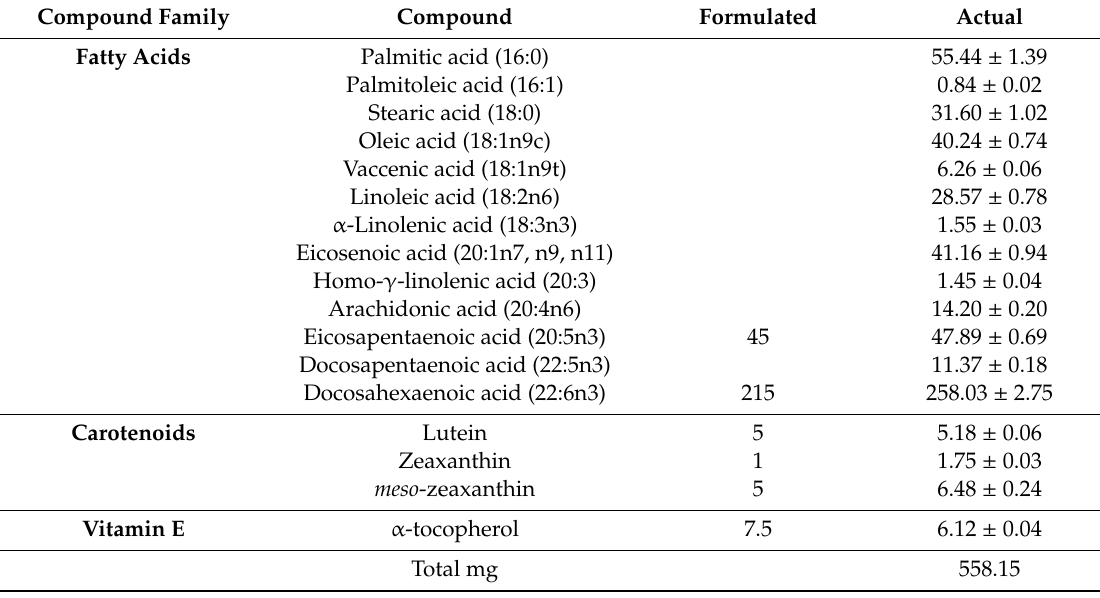
Table A1. Composition of formulation used in CARES Trial 1 (mg / capsule).